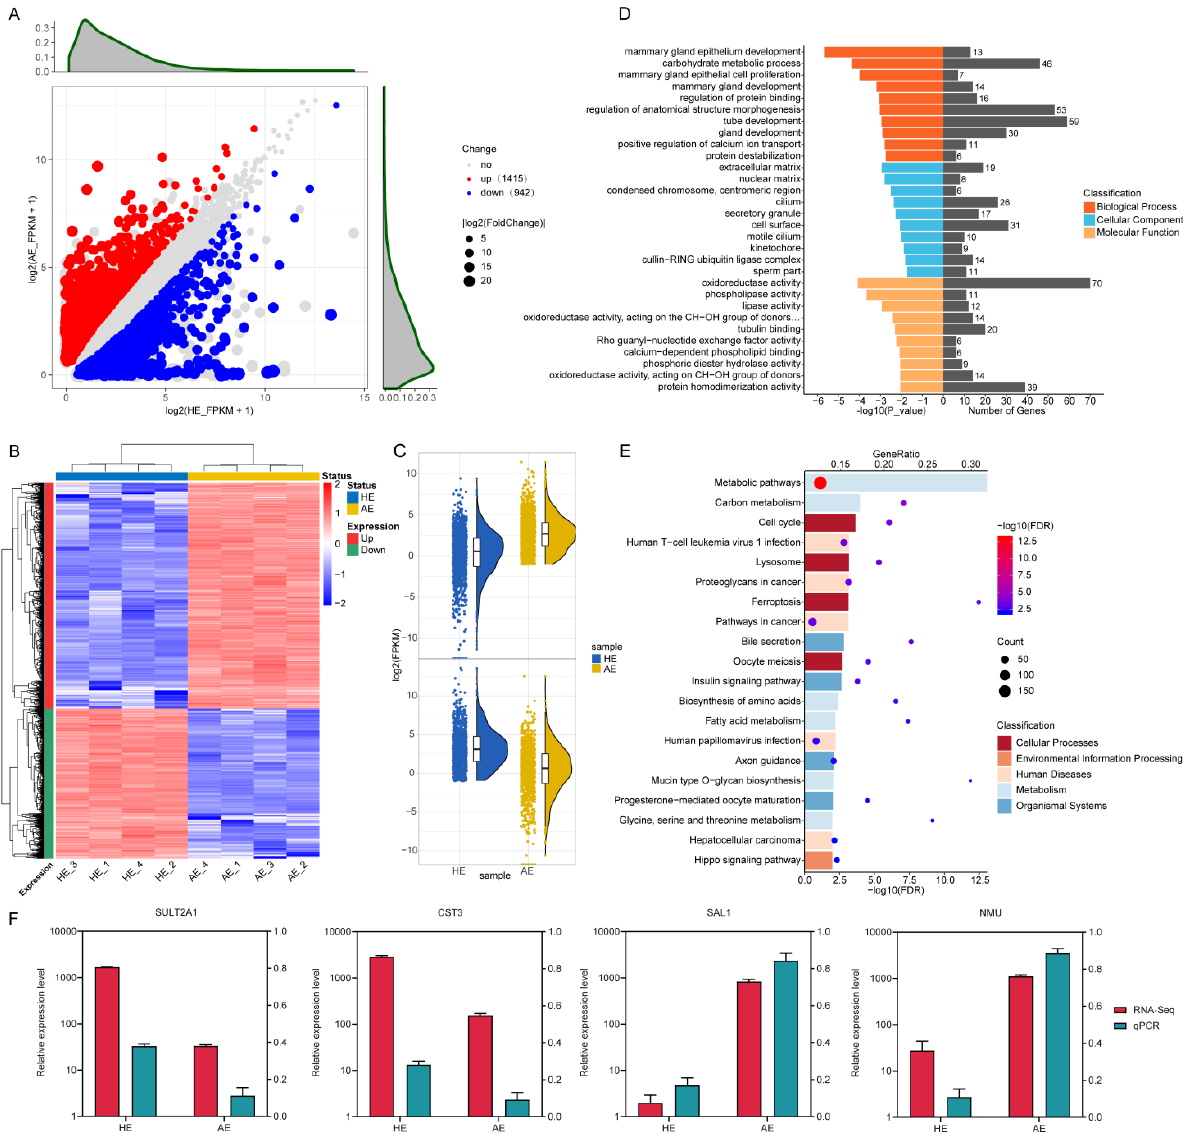
Figure 4. Screening and enrichment analysis of the differentially expressed genes (DEGs) in AE compared with HE. ( A ) DEGs expression level analysis by scatter plot. Each point represents one gene. The red points represent upregulated genes while the blue points represent downregulated genes. ( B ) Hierarchical clustering heatmap of the DEGs. The color scale is from − 2.0 (blue, lower gene expression level) to 2.0 (red, higher gene expression level). Each row represents one gene, and each column represents one sample. The red band on the left side of the heatmap represents the clustered upregulated genes, while the green represents downregulated gene clusters. ( C ) Raincloud plot of upregulated and downregulated DEGs. ( D ) GO enrichment analysis of the DEGs. ( E ) KEGG pathway analysis of the DEGs. The different color represents the categories to which the KEGG pathway belongs. ( F ) Validation of the expression of genes using qRT-PCR. The relative expression level was normalized by log10.